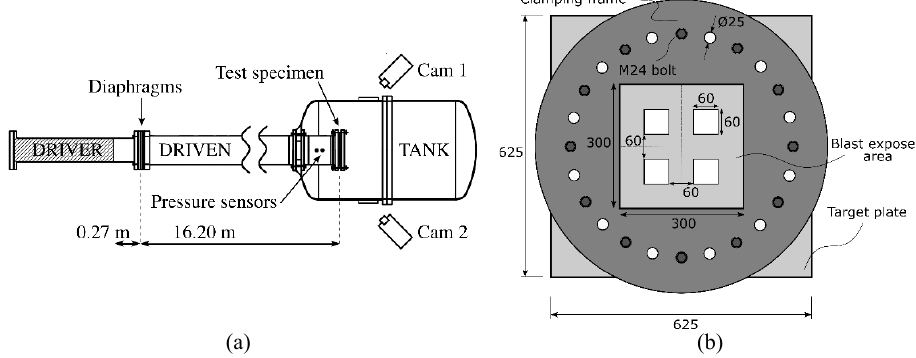
Fig. 2. The SIMLab Shock Tube Facility (SSTF) [9]: (a) a sketch of the entire facility and (b) the geometry of the clamping assembly and the blast-loaded target plates with pre-formed square